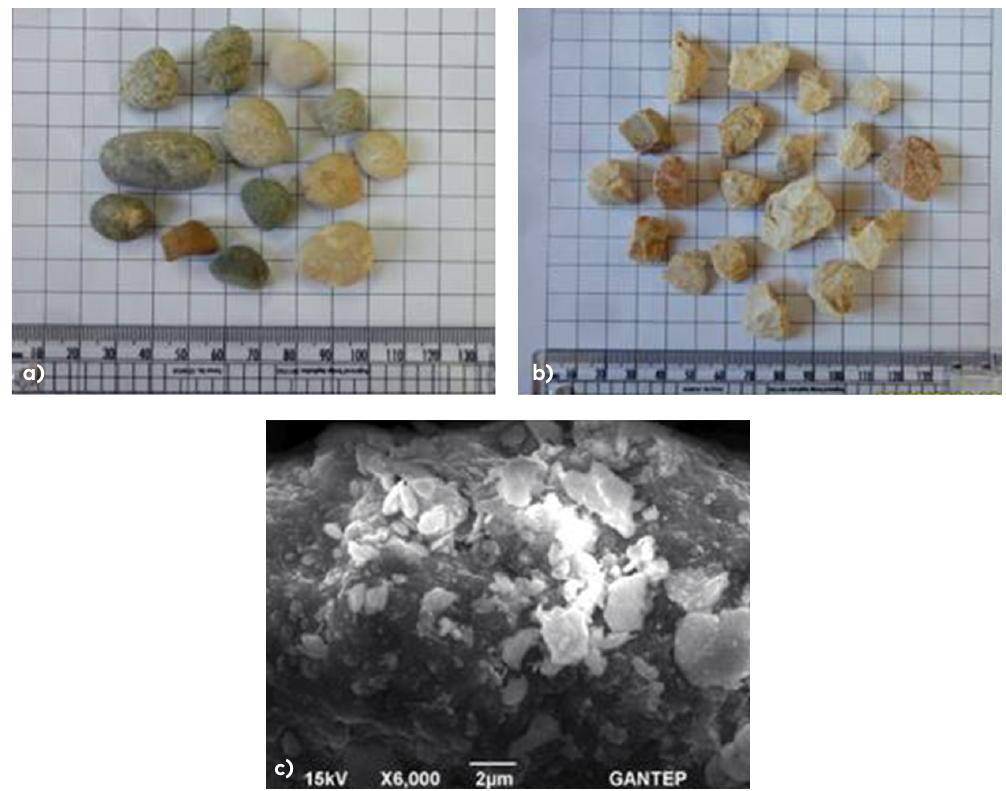
Figure 1. Images of NG (a), CG (b), and SEM of clay (c) used